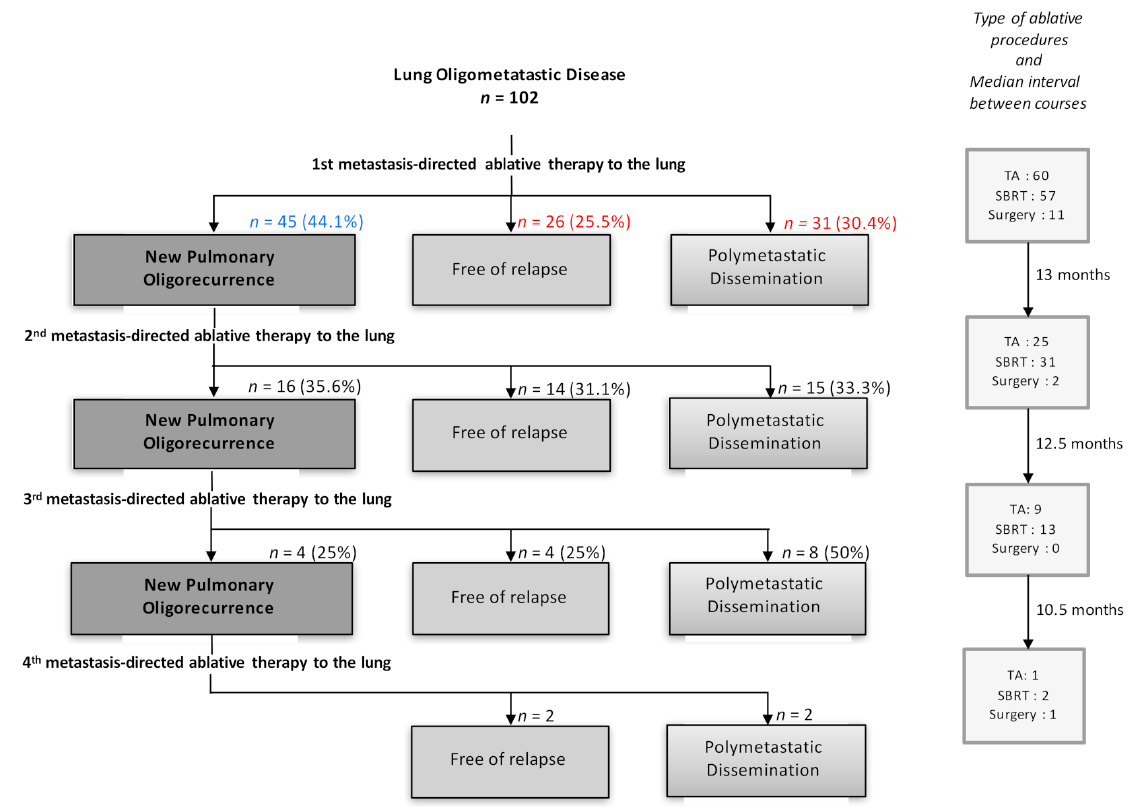
Figure 1. Recurrence profiles of the patients treated with multiple (in blue) or single (in red) lung metastasis-directed ablative therapies. n : number of patients; TA: thermo-ablation procedures; SBRT: stereotactic body radiotherapy. The colored numbers indicate the number of patients in the “single course” group (blue) and the “multiple courses” group